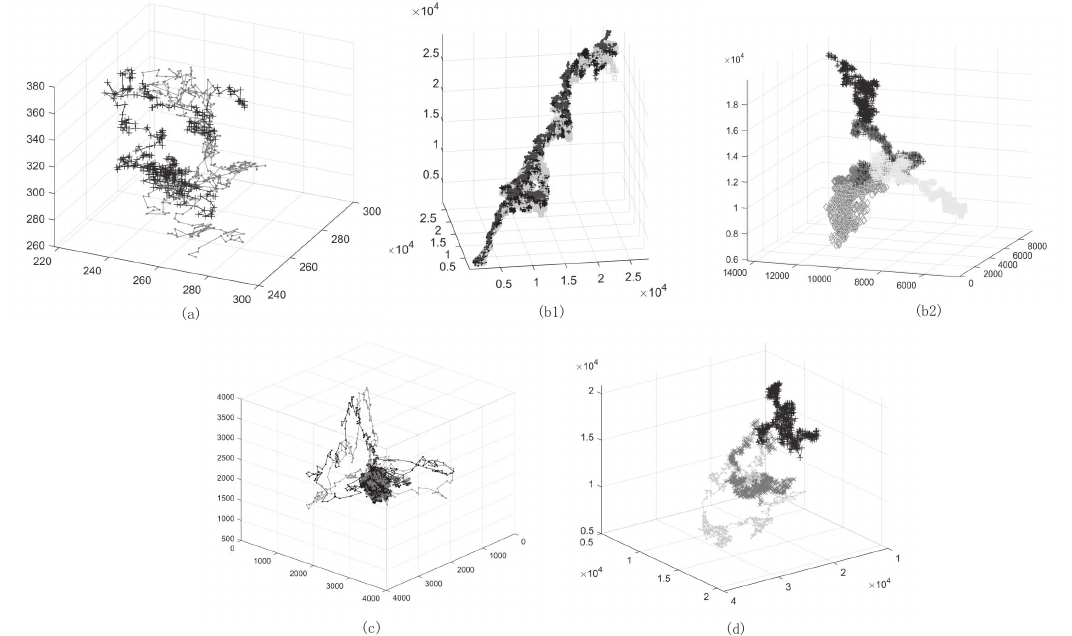
Figure 4. Attractor of four datasets: ( a ) AUL8, ( b1 ) DJI with an unsuitable time delay τ , ( b2 ) DJI, ( c ) GEI and ( d ) NIKKE225 in the phase